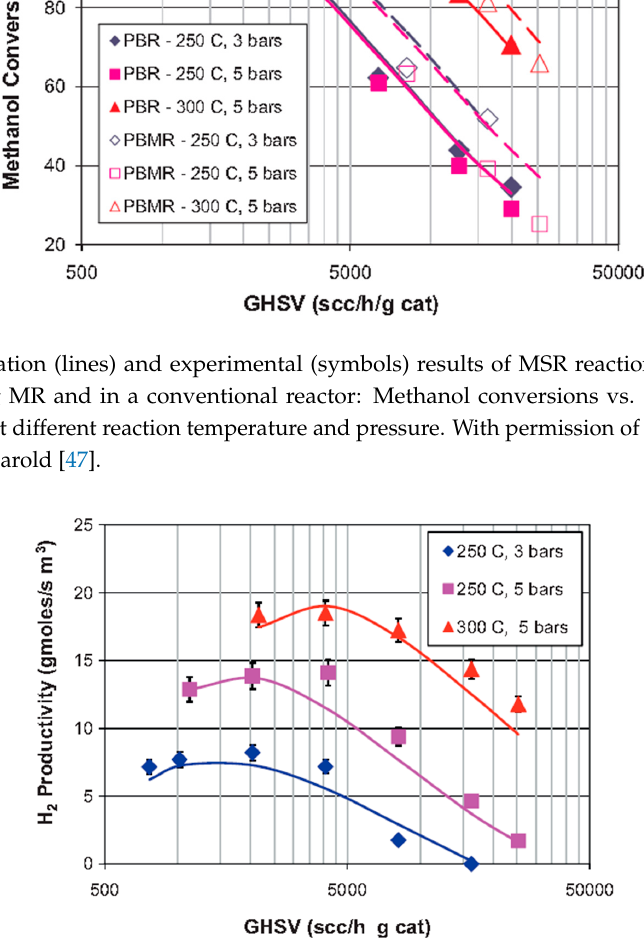
Figure 14. Simulation (lines) and experimental (symbols) results of MSR reaction carried out in a supported Pd-Ag MR and in a conventional reactor: H 2 productivities vs GHSV at different reaction temperature and pressure. With permission of reprint of Elsevier from Israni and Harold [47].